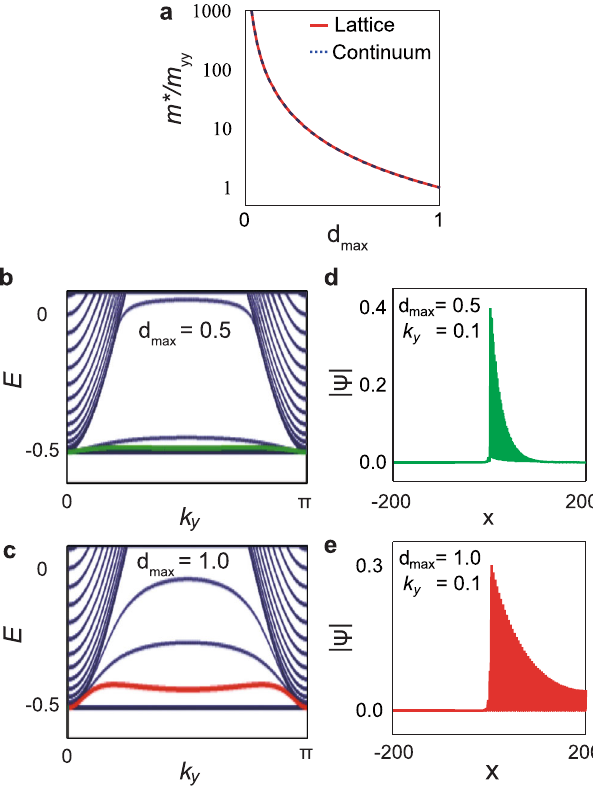
Fig. 4 Band structure and interface modes of the square lattice fl at-band model. a The effective mass of the interface mode calculated from the lattice and continuum models are plotted as a function of d max . b and c Band structures of the square lattice models at d max ¼ 0 : 5 ( c ) and 1 ( d ), where an interface is introduced by applying an onsite potential U 0 = − 0.5 for x > 0. Interface bands are represented by green and red colors. The other edge bands are from open boundaries, which are not the focus of this study. In d and e , the wave functions of interface modes at k y = 0.1 are plotted for d : 5 and 1, respectively. In all fi gures, the mass tensor for max ¼ 0